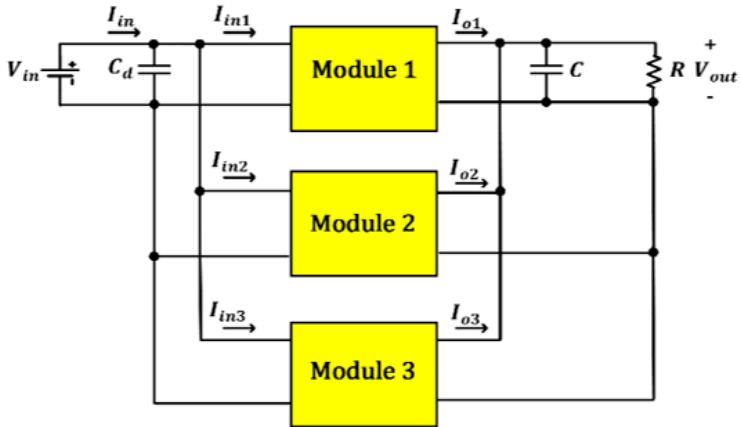
Figure 3. Input-Parallel Output-Parallel (IPOP) DC-DC converter circuit diagram.